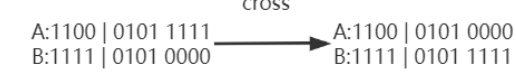
Figure 5. Crossover operation.